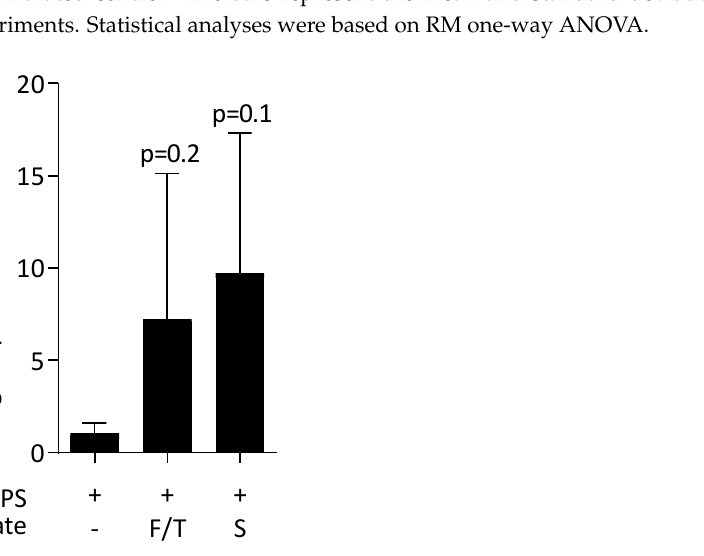
Figure 4. ST2 lysates increase M2 polarization in primary macrophages. Primary bone-marrow-derived macrophages were exposed to ST2 lysates prepared by freeze/thawing (F/T) and sonication (S). The expression changes of arginase-1 (Arg1) were normalized to an unstimulated control. The bars represent the mean and standard deviation of four independent experiments. Statistical analysis was based on Friedman test.